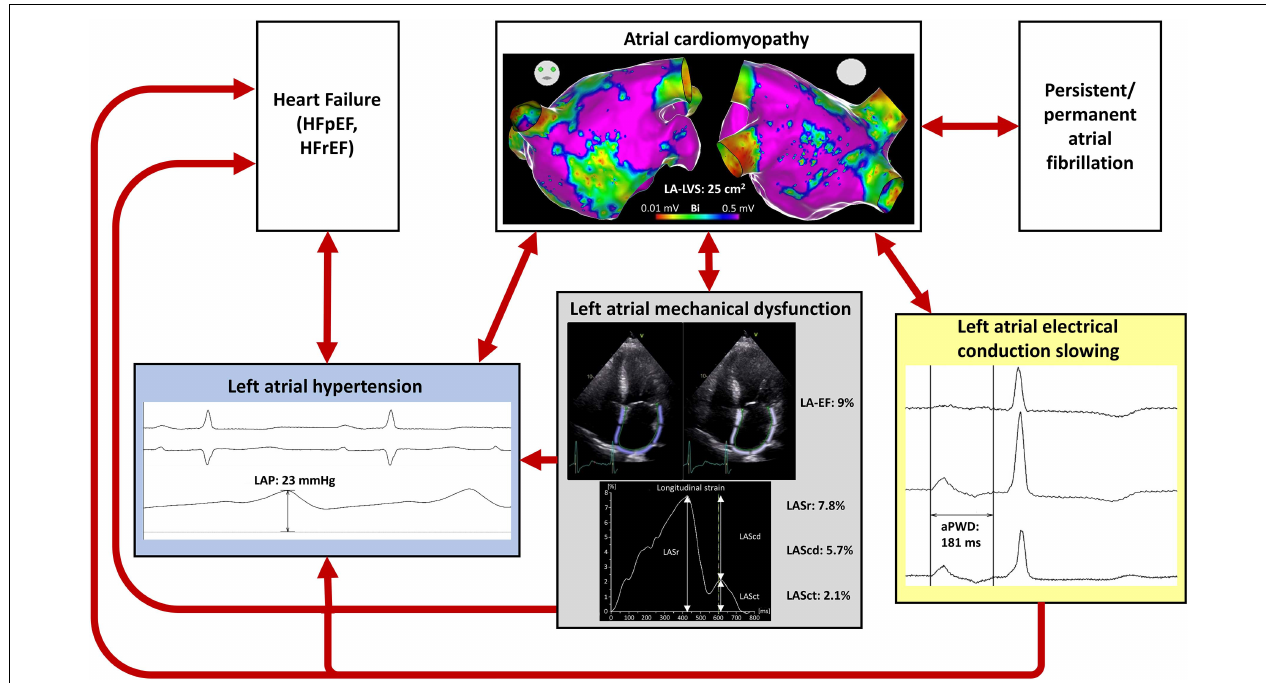
FIGURE 6 | Pathophysiology of atrial cardiomyopathy (ACM). This illustration summarizes the pathophysiology of ACM and the diagnostic possibilities to detect the different pathophysiological mechanisms. The representative patient illustrated has a relevant ACM with a left atrial low-voltage substrate (LA-LVS) at 0.5 mV threshold of 25 cm 2 , a hypertensive left atrial pressure (LAP) of 23 mmHg, an impaired left atrial emptying fraction (LA-EF) of 9%, an impaired left atrial strain during reservoir phase (LASr) of 7.8%, during conduit phase (LAScd) of 5.7%, and during contraction phase (LASct) of 2.1% as well as a prolonged amplified p-wave duration (aPWD) of 181